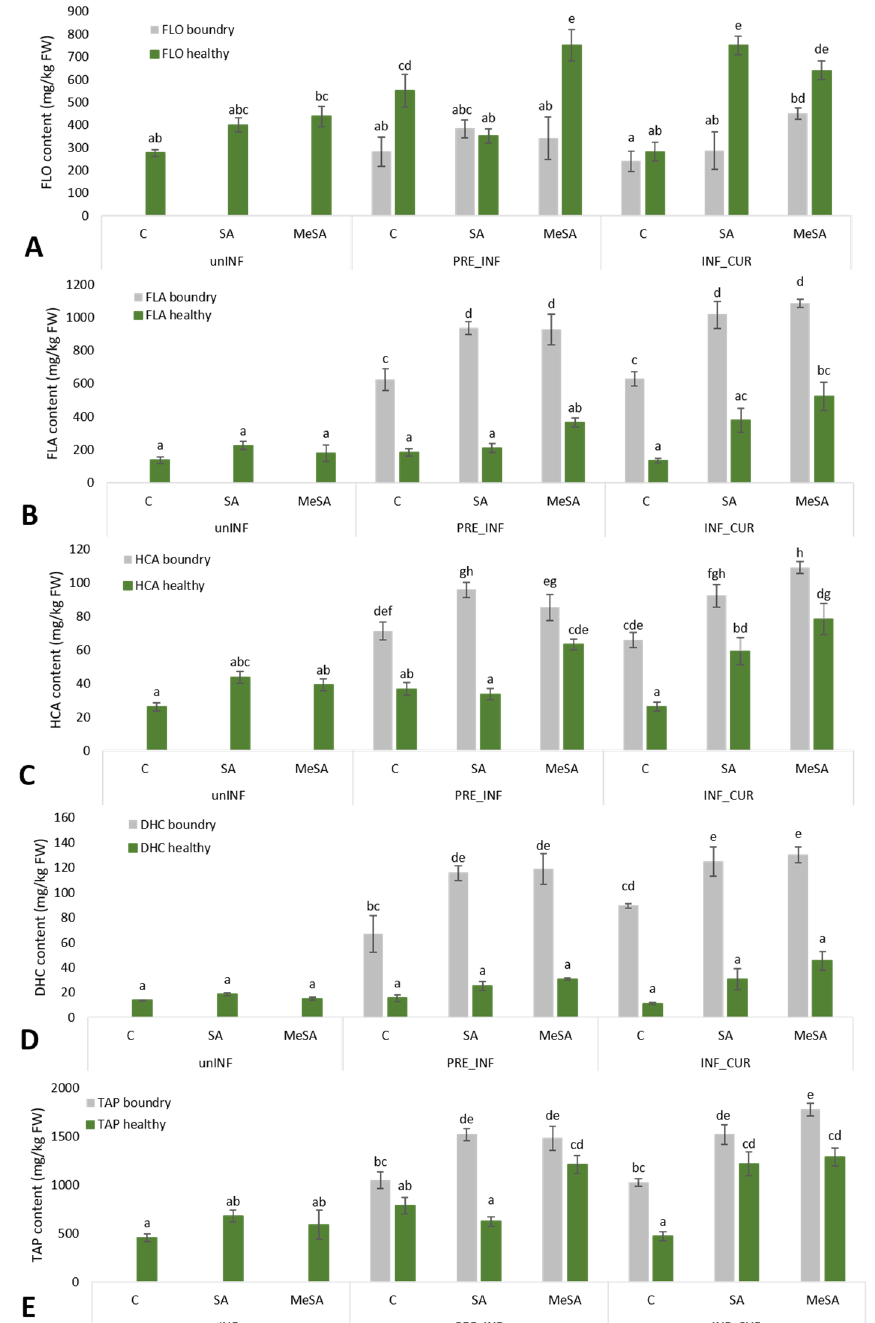
Figure 2. Flavonols ( A ), flavanols ( B ), hydroxycinnamic acids ( C ), dihydrochalcones ( D ) and total analyzed phenolic (TAP) ( E ) content in uninfected healthy tissue of apple peel treated with salicylic acid (SA) and methyl salicylic acid (MeSA) and in M. laxa infected healthy and boundary tissue around the lesion, preventively or curatively treated with SA and MeSA. Data are means ± standard error. Different letters indicate significant difference between treatments ( p < 0.05; Tukey tests).